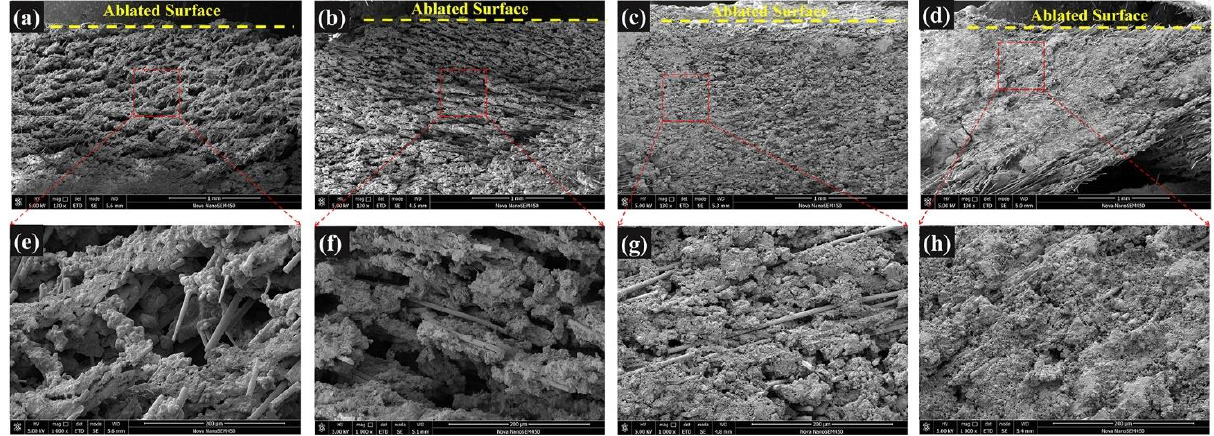
Figure 10. Cross-sectional microstructure of ceramic layer: SF-0.5 ( a , e ); SF-1 ( b , f ); SF-3 ( c , g ); SF-6 ( d , h ).